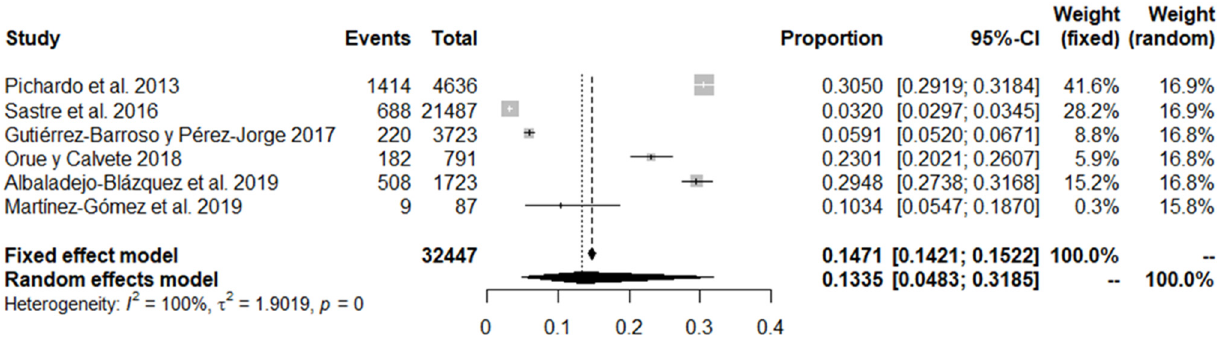
Figure 3. Forest plot of bullying perpetration studies.